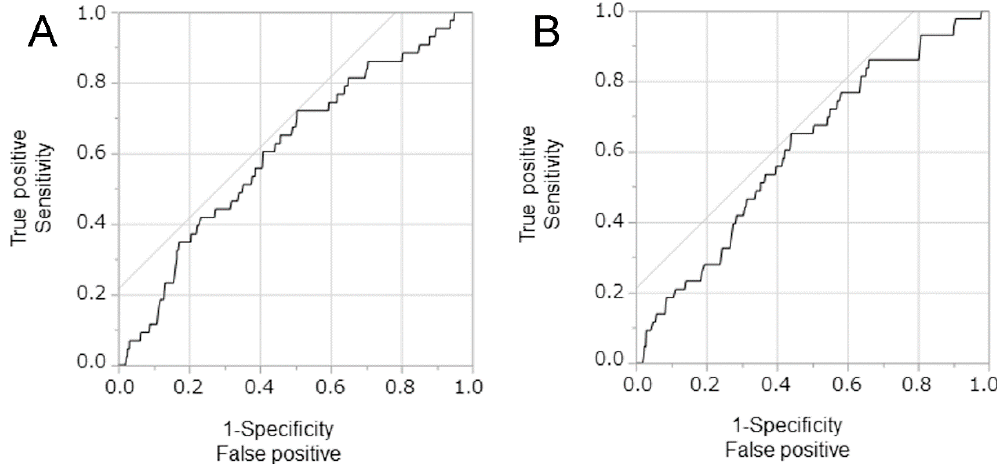
Figure 5. Receiver Operator Characteristic curves of a positive blood culture of Bacillus spp. ( A ) Prediction using the temperature alone and ( B ) prediction based on temperature plus absolute humidity. The relationships between sensitivity (true positives) and 1-specificity (true negatives) in determining the diagnostic performances of these climatological variables for predicting a positive blood culture of Bacillus spp. In both panels, the time lag of six days was taken.